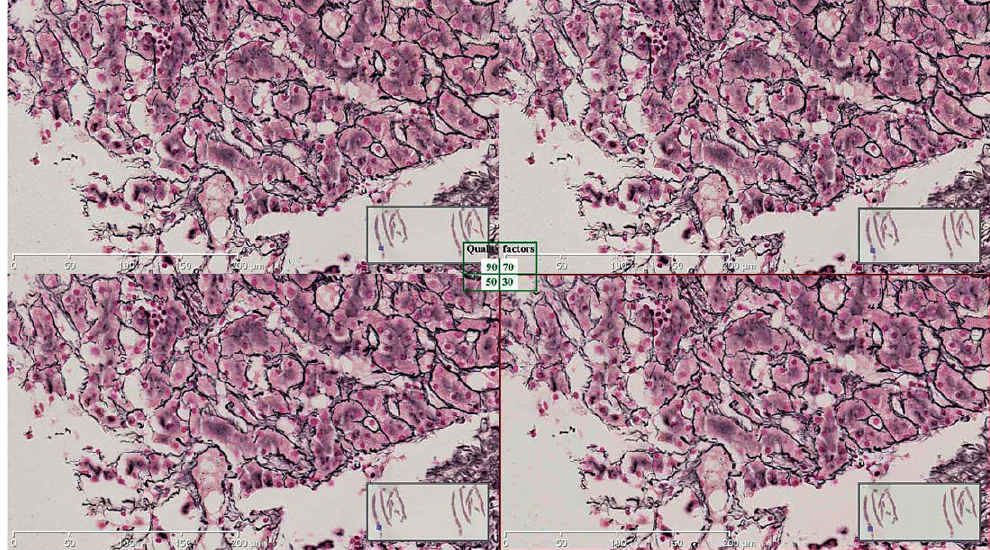
Fig. 1. Four images of the same area on a Reticulin slide at quality factors as 70, 30, 50, 90 (clockwise from top right) look similar.